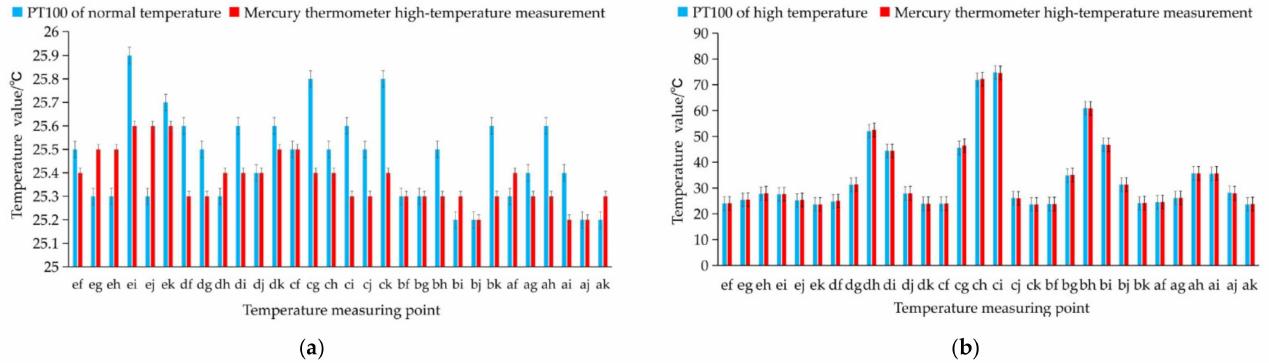
Figure 20. Normal temperature soil and soil temperature after microwave irradiation measured by two kinds of sensors: ( a ) soil temperature at room temperature; ( b ) soil temperature after 2 min of microwave